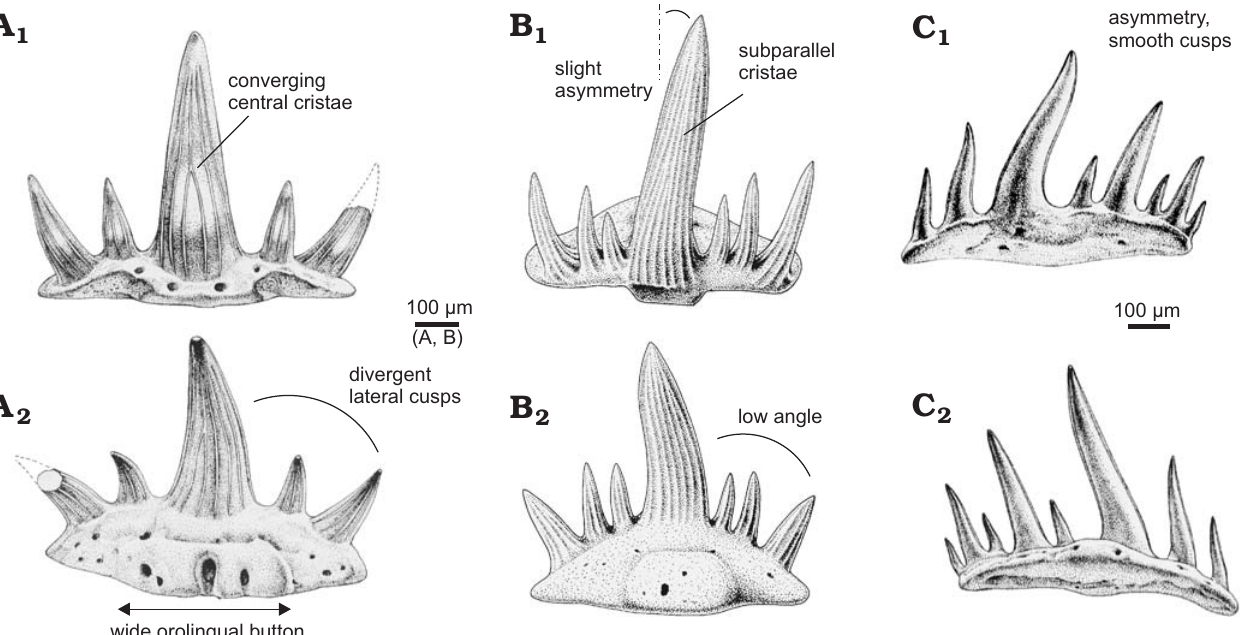
Fig. 7. Comparative drawings of selected falcatid species from the upper Mississippian with a few diagnostic morphological terms. A . The holotype of “ Stethacanthus” gansuensis Wang, Jin, and Wang, 2004 (IVPP V 13666.1) from the Serpukhovian of Qilian Mountain, Gansu, China, in labial (A 1 ) and lingual (A 2 ) views. B . Denaea cf. fournieri (ZPAL P. IV/221) from the Viséan of Todowa Grz ą ba, Holy Cross Mountains, Poland, in labial (B 1 ) and lingual (B 2 ) views. C . The holotype of Denaea wangi Wang, Jin, and Wang, 2004 (IVPP V 13668.1) from the Serpukhovian of Qilian Mountain, Gansu, China, in labial (C 1 ) and lingual (C 2 ) views. A, C modified from Wang et al.